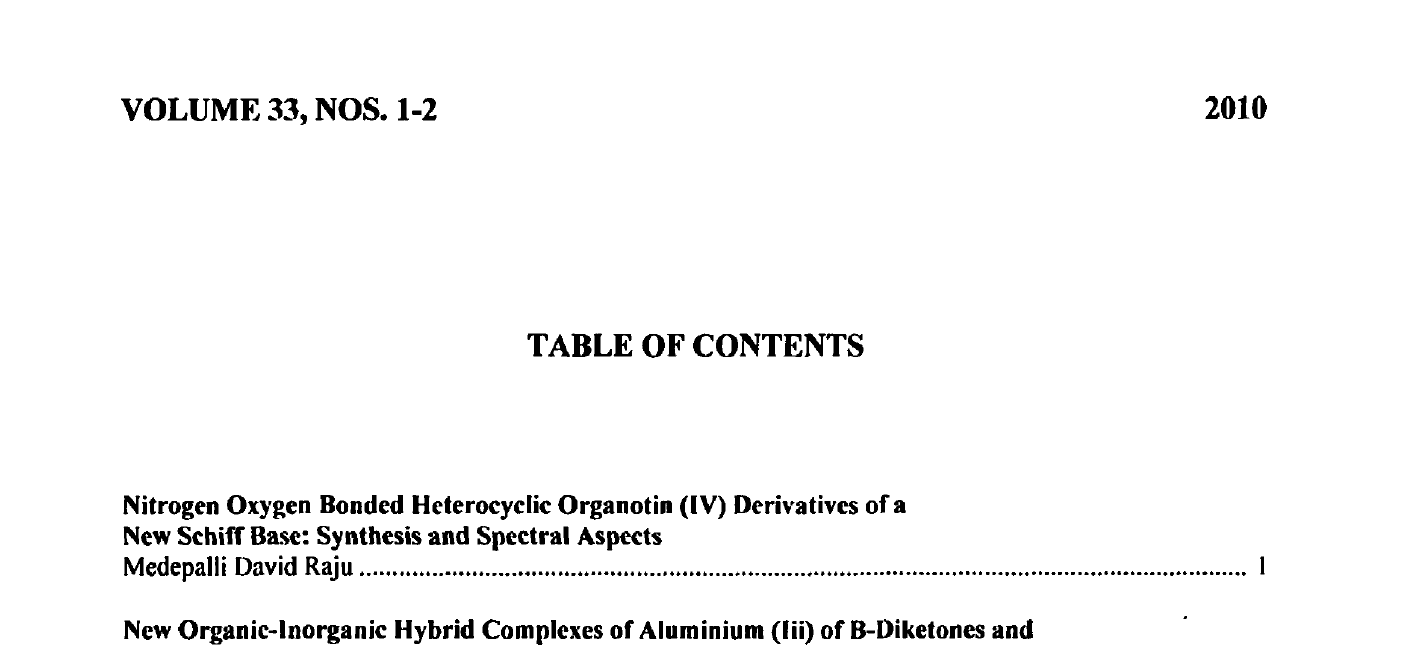
New Organic-Inorganic Hybrid Complexes of Aluminium (lii) of B-Diketones and Sterically Demanding Heterocyclic B-Diketones: Synthesis, Structural Aspects and Spectroscopic |lr and N m r ('h, 13 c and 27 al) Characterization